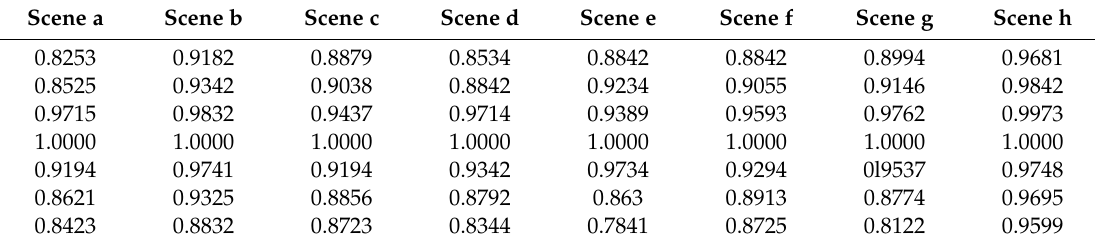
Table 3. The change of the variance function during focusing in di ff erent scenes.